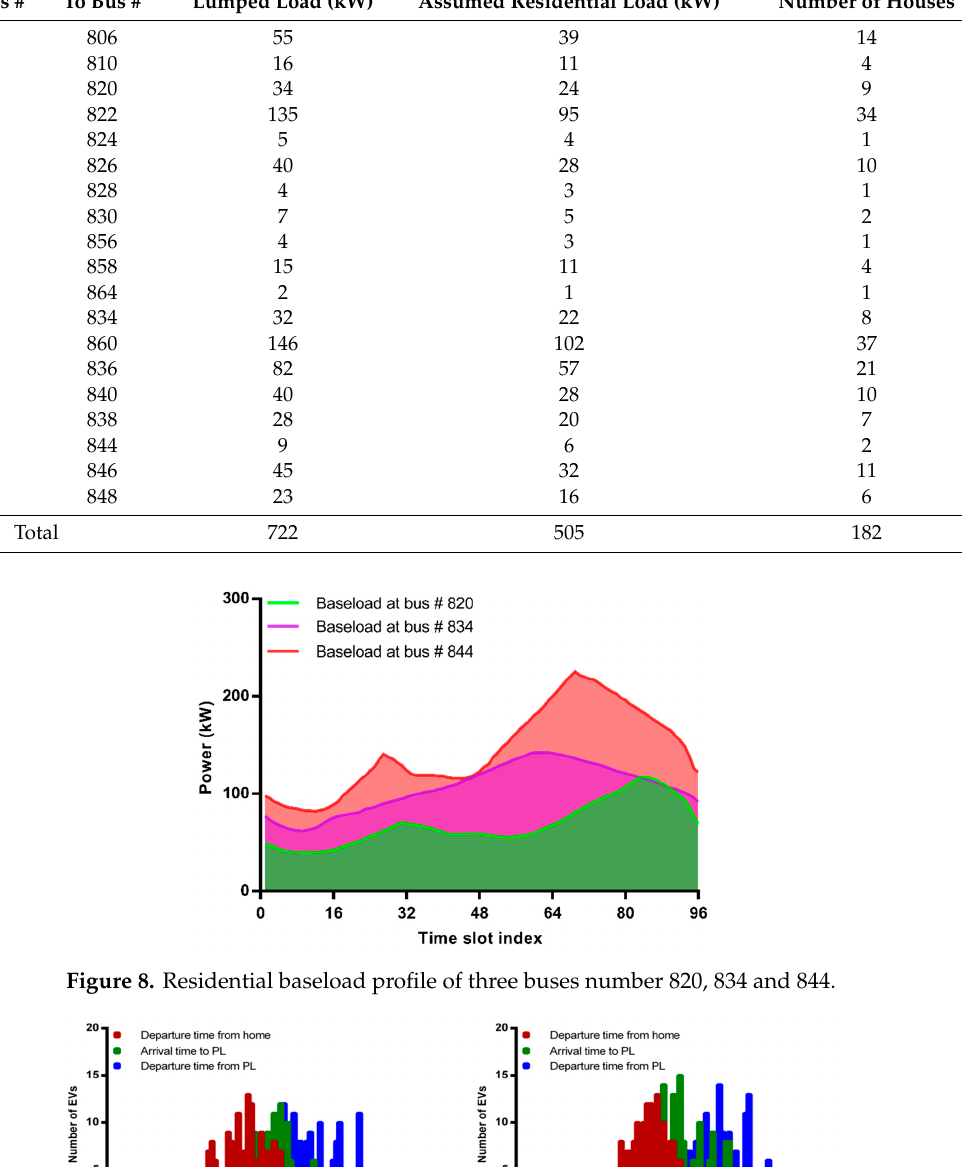
Table 6. IEEE 34 node test feeder- distributed load.